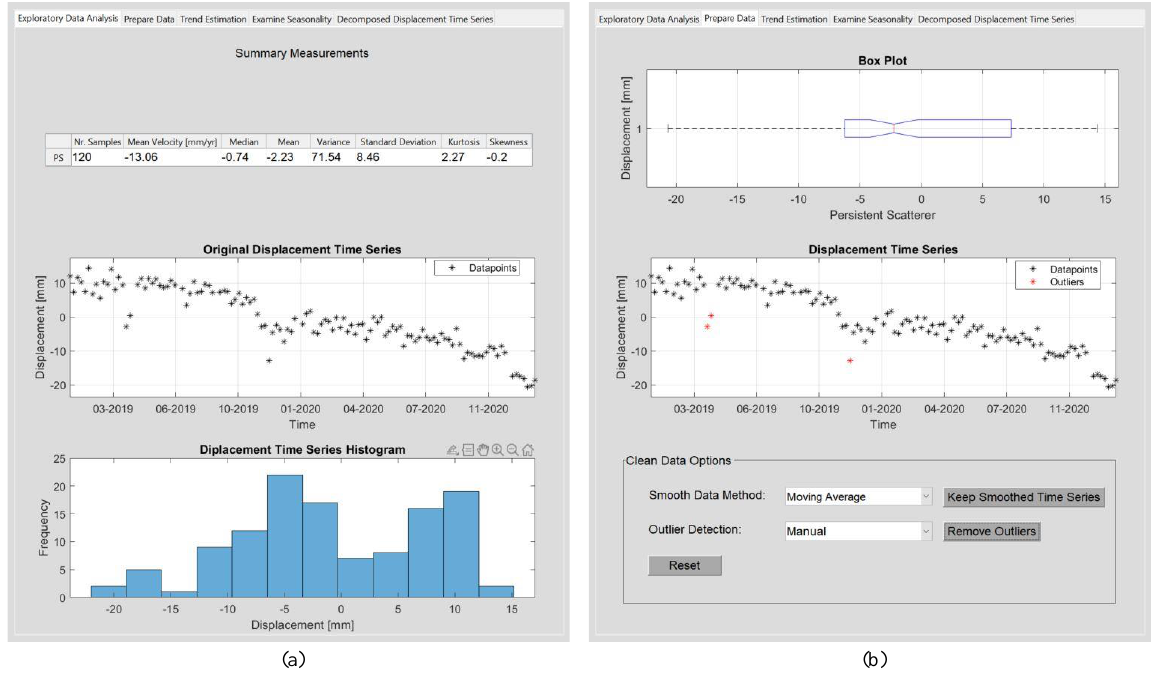
Figure 6 . EDA (a) and outlier detection (b) of the time series of PS 1. the option to select a CP manually. The semi-automatic